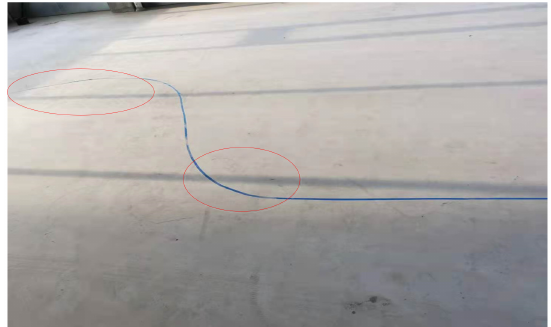
Figure 17. “S-bend” test